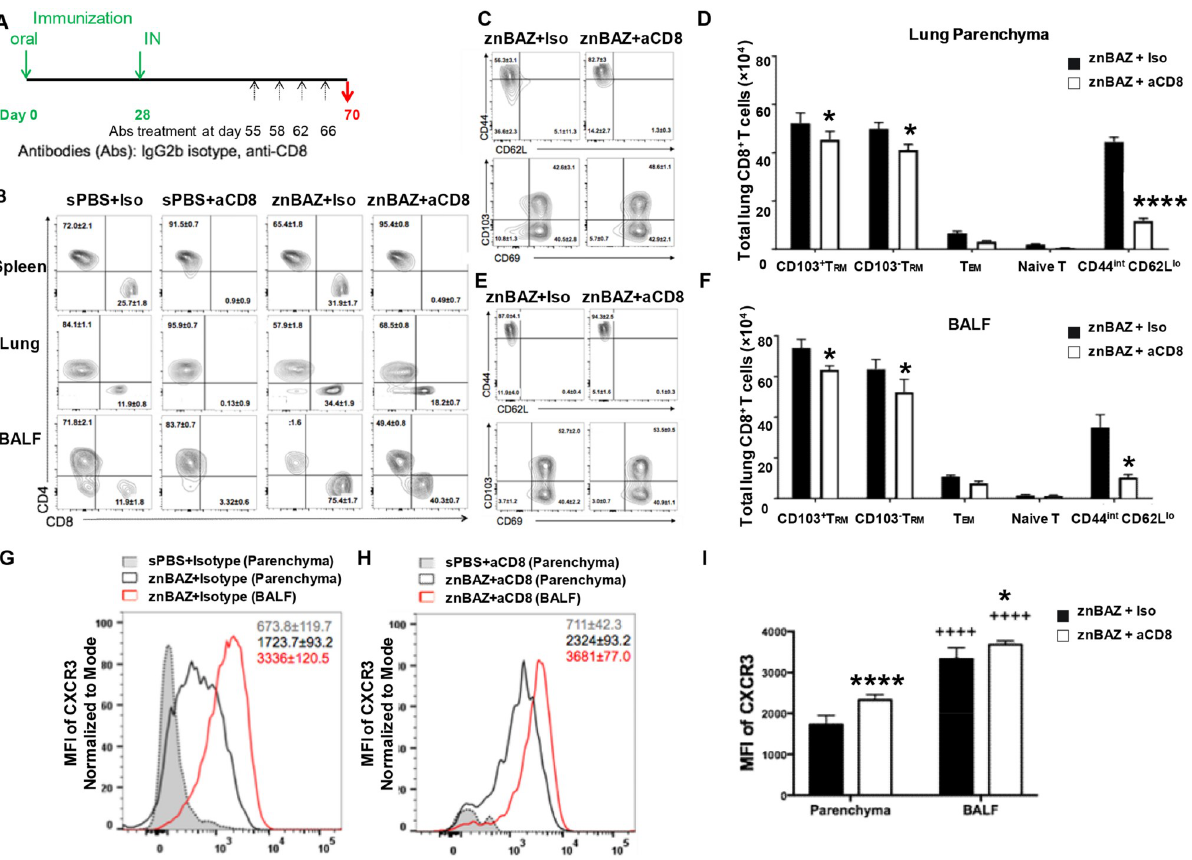
Fig 7. Mucosal znBAZ vaccination elicits CXCR3 lo and CXCR3 hi , CD8 + T RM cell subsets that are enriched in lung parenchyma and BALF. (A) BALB/c mice were primed/boosted with sPBS or znBAZ as depicted. On days 55, 57, 62, and 66, mice were treated IP with isotype or anti-CD8 mAb. On day 70, mice were evaluated for extent CD8 + T cell infiltration into the lung parenchyma and airways without wt challenge. (B) Flow cytometry analysis of CD4 + and CD8 + expression on TCR- β + cells from spleen, lung parenchyma, and BALF following isotype or anti-CD8 mAb treatment in sPBS- and znBAZ-vaccinated mice. FACS plots show the expression of CD44, CD62L, CD103, and CD69 on CD8 + T cells from (C) lung parenchyma and (E) BALF. Total CD103 + CD8 + T RM , CD103 - CD8 + T RM , T EM , na ï ve T cells, and CD44 int CD62L lo CD8 + T cells are shown from the (D) lung parenchyma and (F) BALF. The data depict n = 12 mice per group combined from three independent experiments; the difference between isotype and anti-CD8 mAb was determined by ���� P < 0.0001, ��� P < 0.001, �� P < 0.01, � P < 0.05. The differences between lung parenchyma and BALF were determined to be significant: ++++ P < 0.0001, +++ P < 0.001, ++ P < 0.01, + P < 0.05; analysis of variance with Two-way ANOVA Tukey‘s multiple comparisons test. (G-H) Histograms of CXCR3 expression by CD8 + T cells from the lung parenchyma and BALF are depicted of mice treated with (G) isotype or (H) anti-CD8 mAb, and (I) their respective MFIs are depicted; the differences between isotype and anti-CD8 mAb are indicated as ���� P < 0.0001, � P < 0.05; and the differences between lung parenchyma and BALF are indicated as ++++ P <